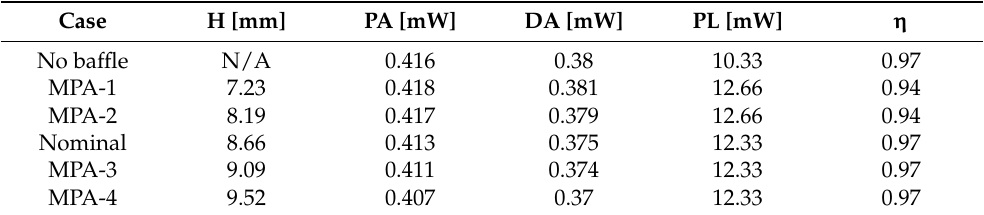
Table 15. Power Loss (PL) and Efficiency ( η ) as a function of H, M PA-PA, DA, and η .